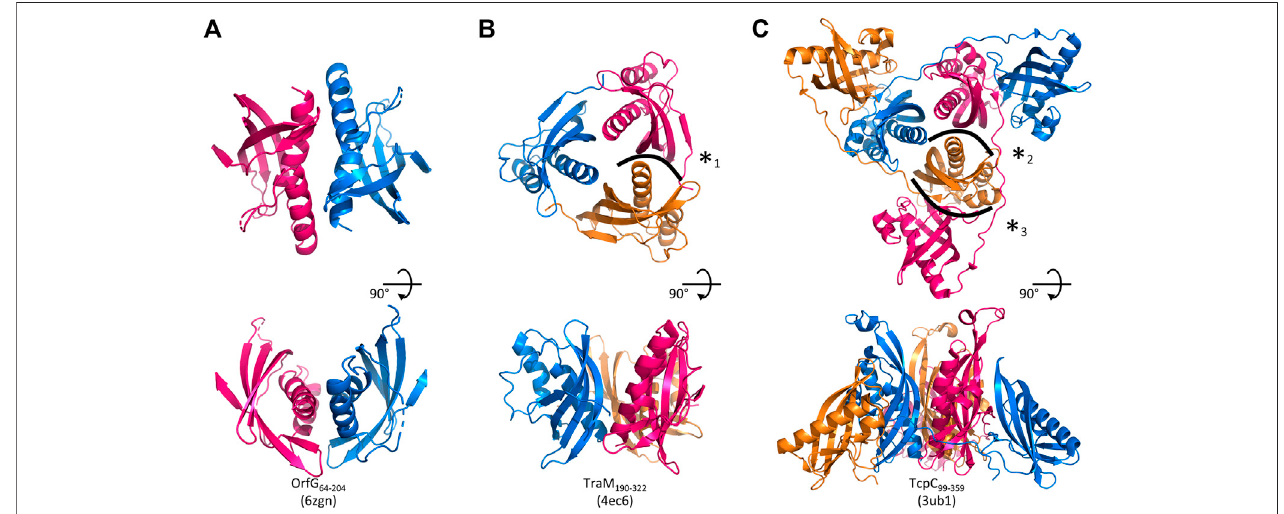
FIGURE 5 | Assemblies of Gram-positive VirB8-like proteins observed in the crystals. A crystallographic 2-fold axis relates two monomers of OrfG 64 – 204 (PDB id 6zgn) (A) , whileTraM 190 – 322 (4ec6) (B) and TcpC 99 – 359 (3ub1) (C) form trimers. Each assembly is shown perpendicular (top) and parallel (bottom) to its symmetry axis. The interface with the highest surface area, here represented for OrfG 64 – 204 , is resolutely rejected by PISA (Krissinel and Henrick, 2007). Theinterface (*1) in TraM 190 – 322 extendson ∼ 300 Å 2 and involvestwotonine hydrogen bonds or saltbridgesdepending onthe observedmonomer(as calculated byPISAfor residues 214to318 of4ec6).TheequivalentinterfaceinTcpC 99 – 359 (*2)represents ∼ 430 Å 2 (PISAonresidues104 – 228of3ub1)andsixtoninehydrogenbondsorsaltbridgedependingon themonomer.Itisbyfarslighterthantheinterface(*3)observedbetweenthecentraldomain(TcpC 104 – 231 )ofonemonomerandtheC-terminaldomain(TcpC 239 – 359 )ofa second one, which extends on ∼ 980 Å 2 and involves 13 – 14 hydrogen bonds or salt bridges depending on the observed monomer. The structure-based sequence alignment of OrfG, TcpC and TraM available in Figure 6 shows residues involved in these